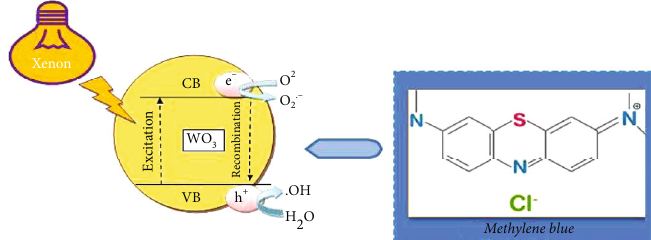
Figure 10: Photocatalyst dye degradation of WO